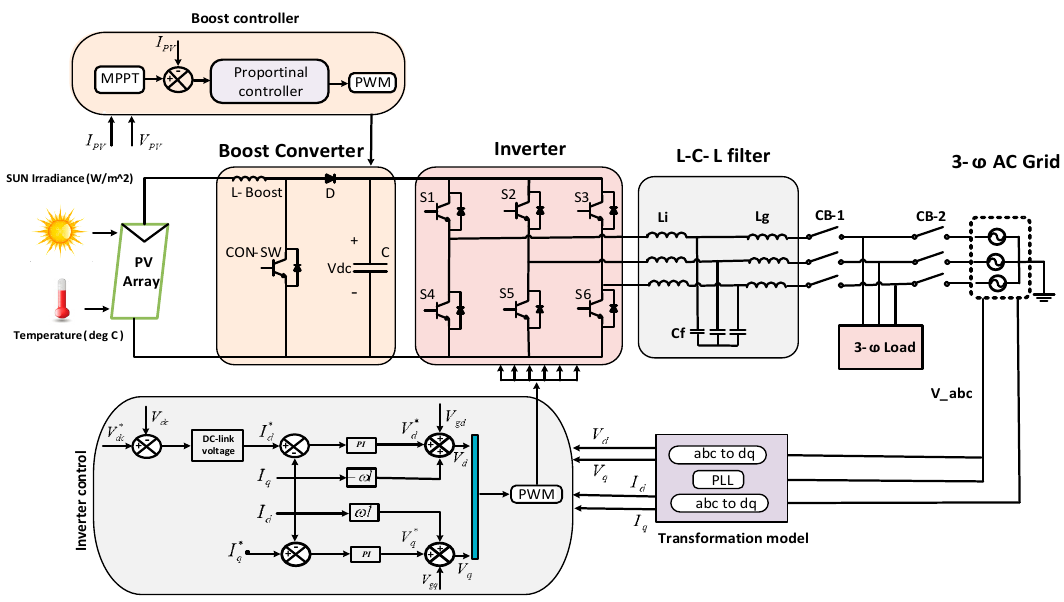
Figure 3. Proposed model for three-phase grid-connected PVS.